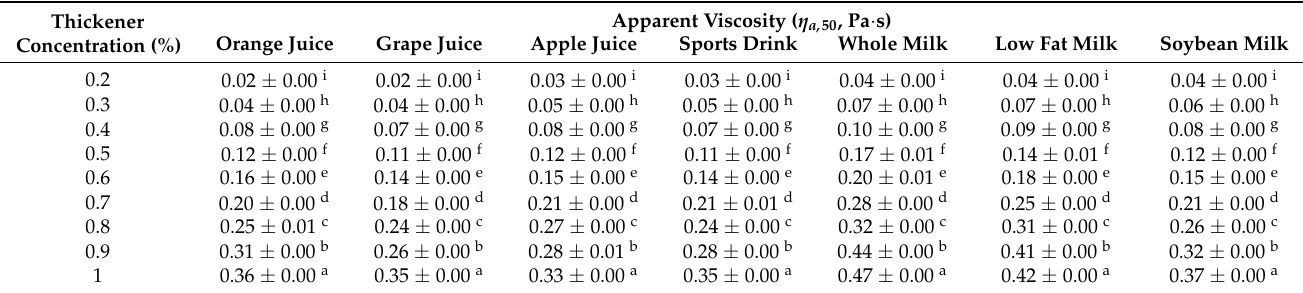
Table 2. Apparent viscosity ( η a, 50 , Pa · s) values of cold thickened beverages with different thickener concentrations. Apparent Viscosity ( η a, 50 , Pa · s) Thickener Orange Juice Grape Juice Apple Juice Sports Drink Whole Milk Low Fat Milk Soybean Concentration (%)